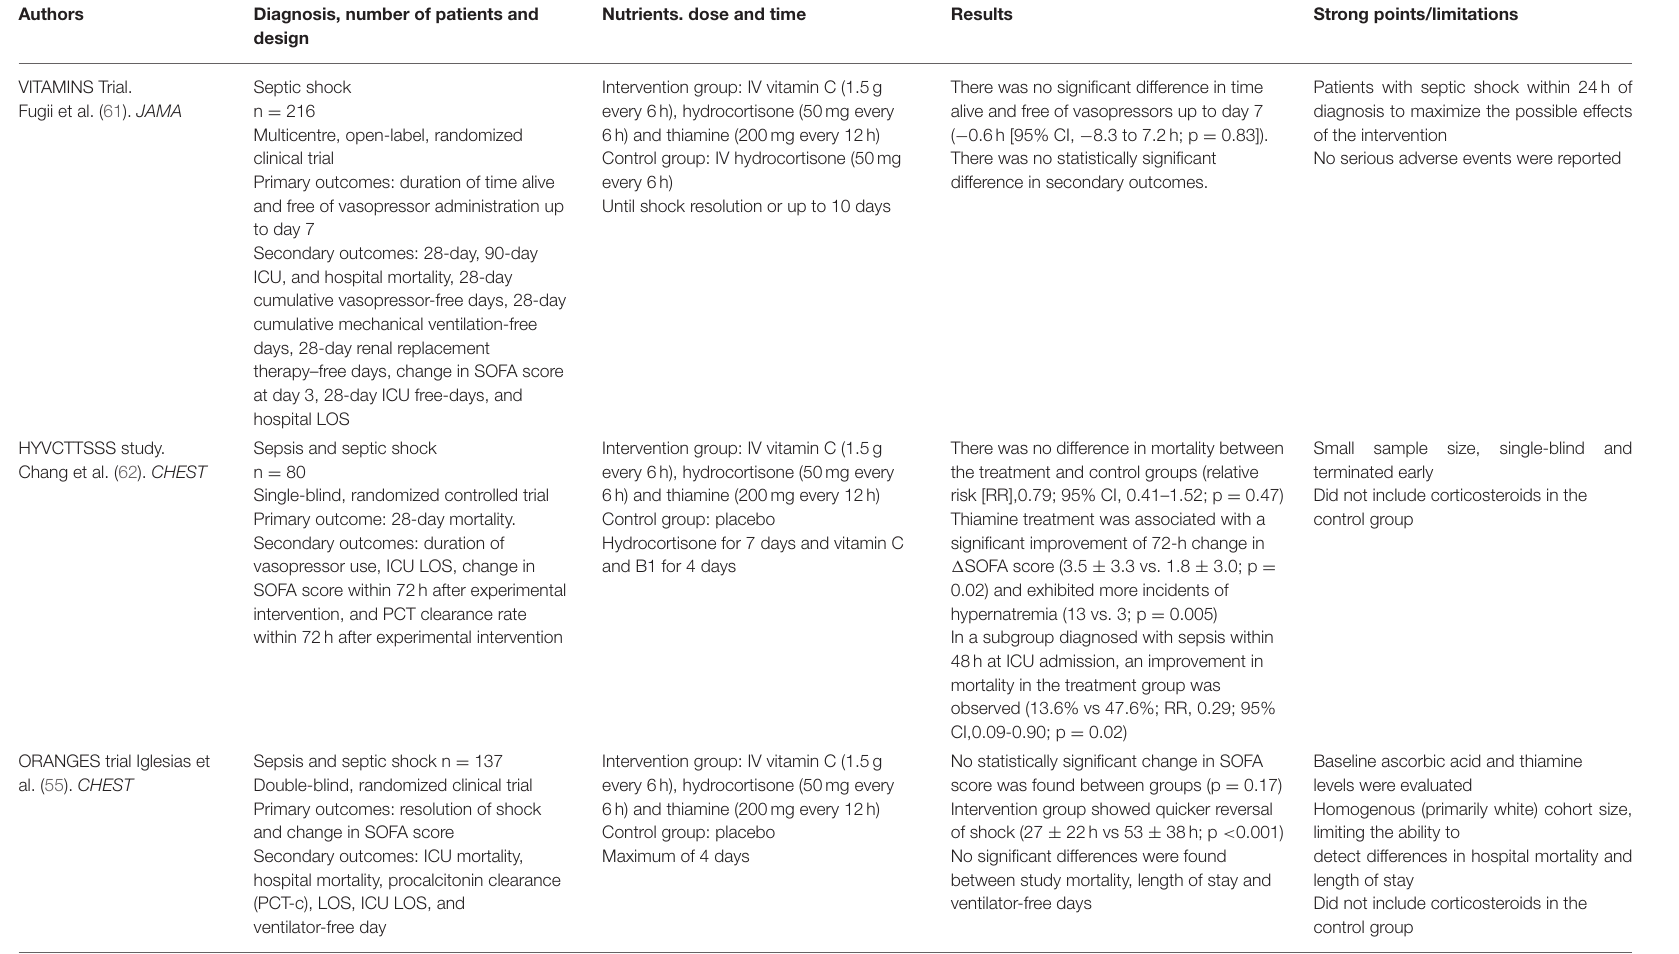
TABLE 2 | Randomized clinical trials evaluating thiamine supplementation as adjunctive therapy in septic shock.